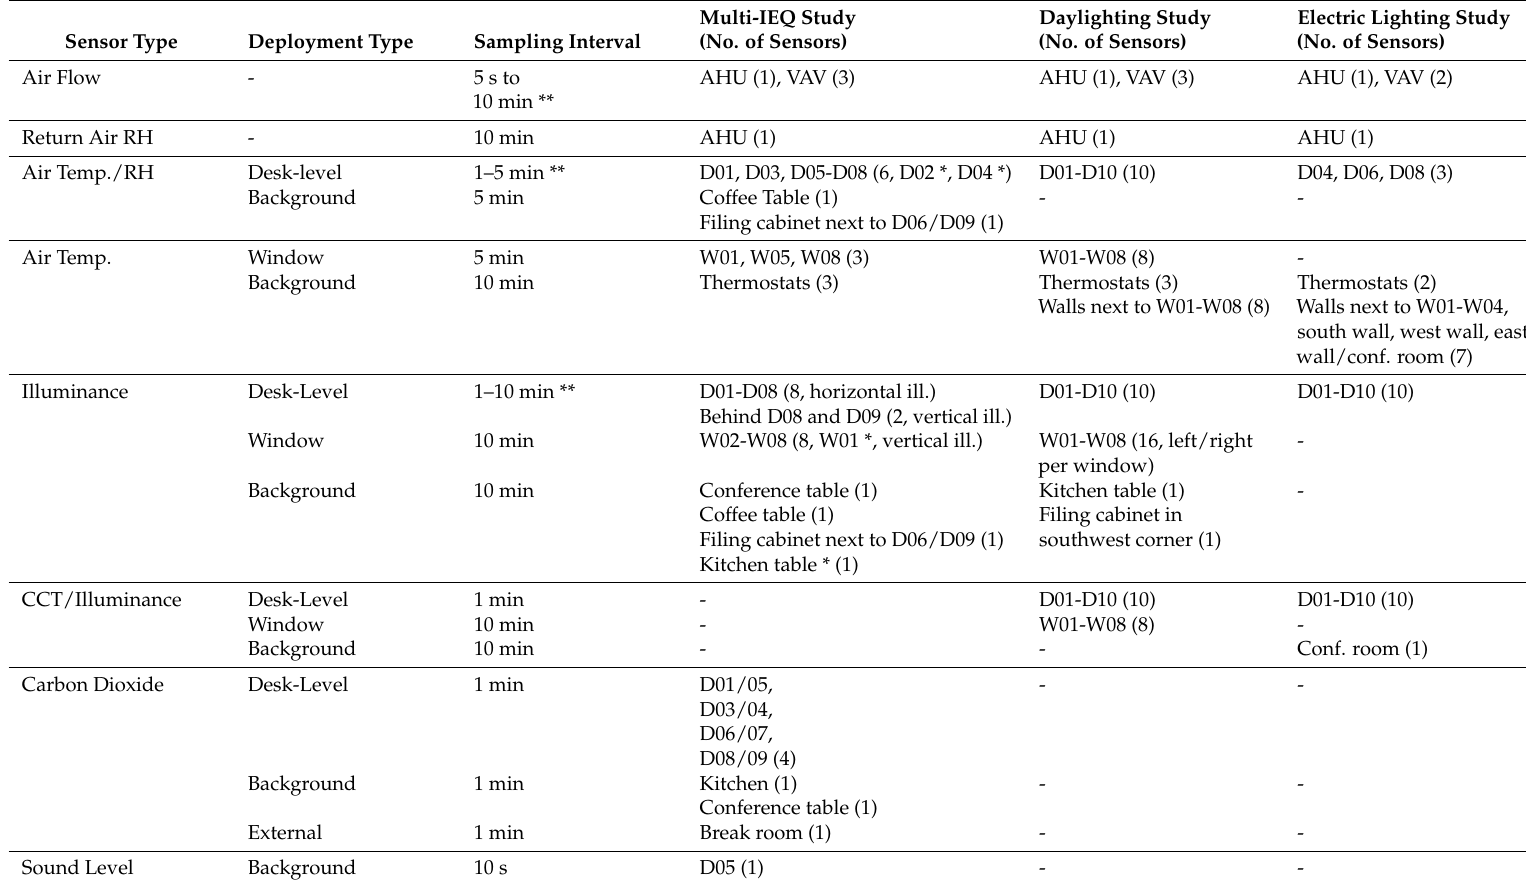
Table 2. Sensor deployment locations for IEQ monitoring during three office